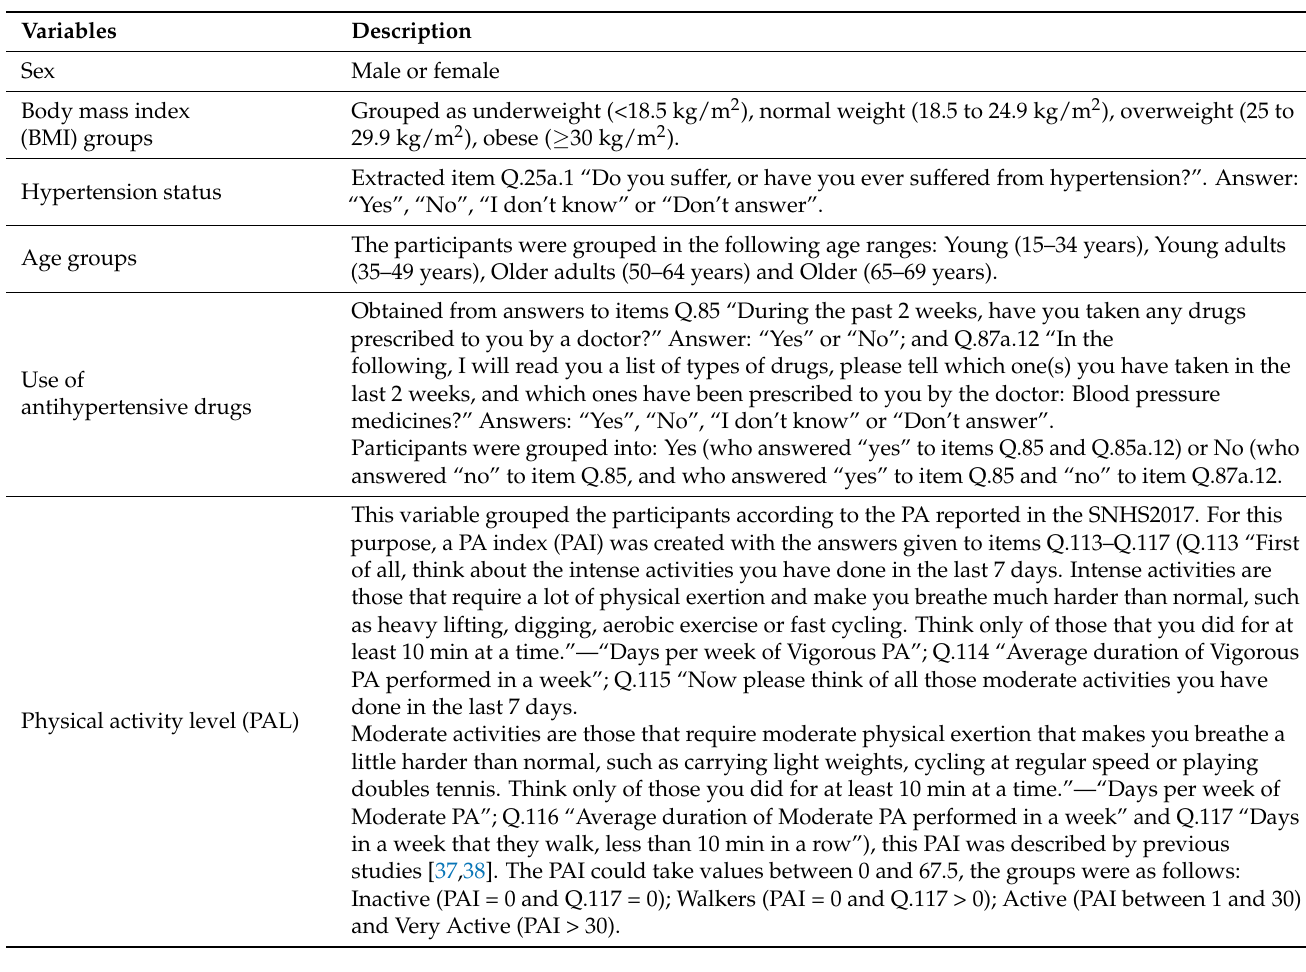
Table 1. Description of